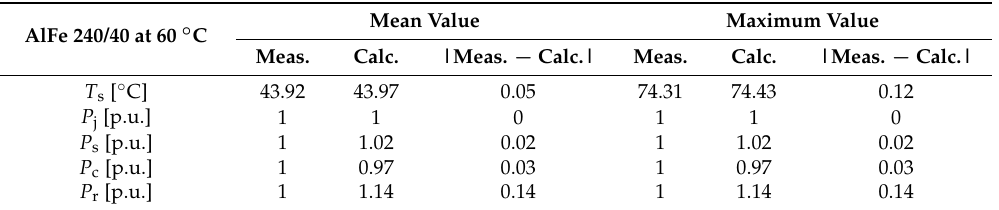
equation parameters after